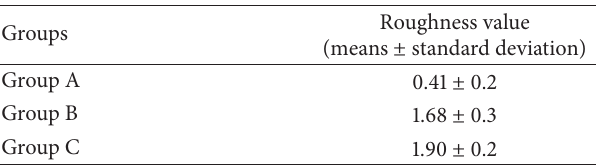
Table 2: Mean surface roughness values according to groups (nine tracings per